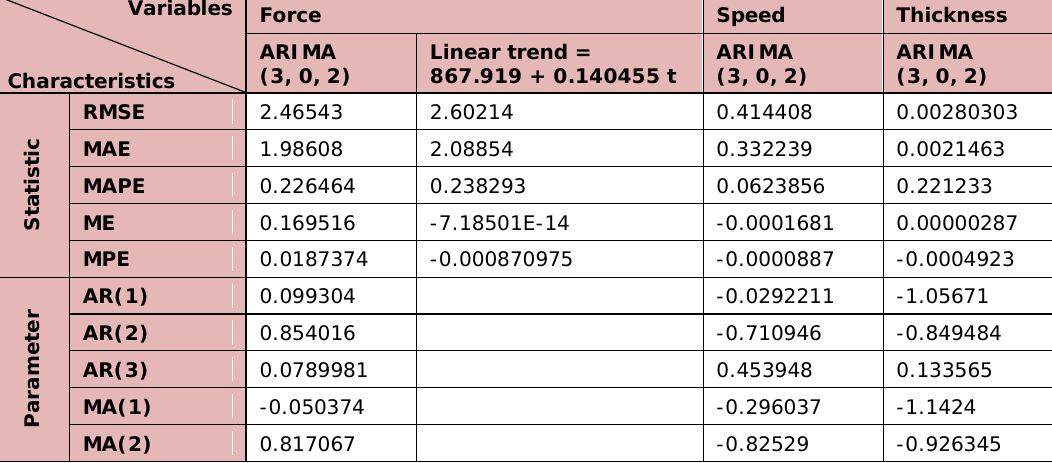
Table 4. “Fitting models of force, speed, and